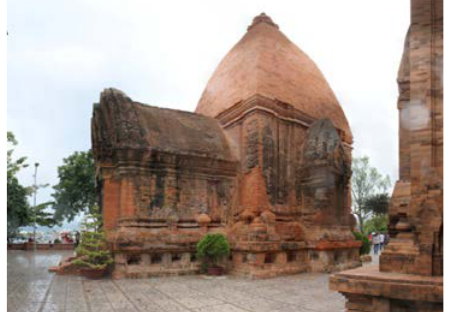
Figure 13. Thu Thien tower. One or the four towers surveyed by laser